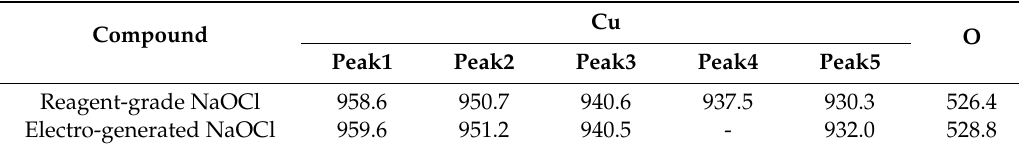
Table 3. Position of components in precipitated Cu species X-ray photoelectron spectrometer (XPS) spectrum. (Unit: eV).